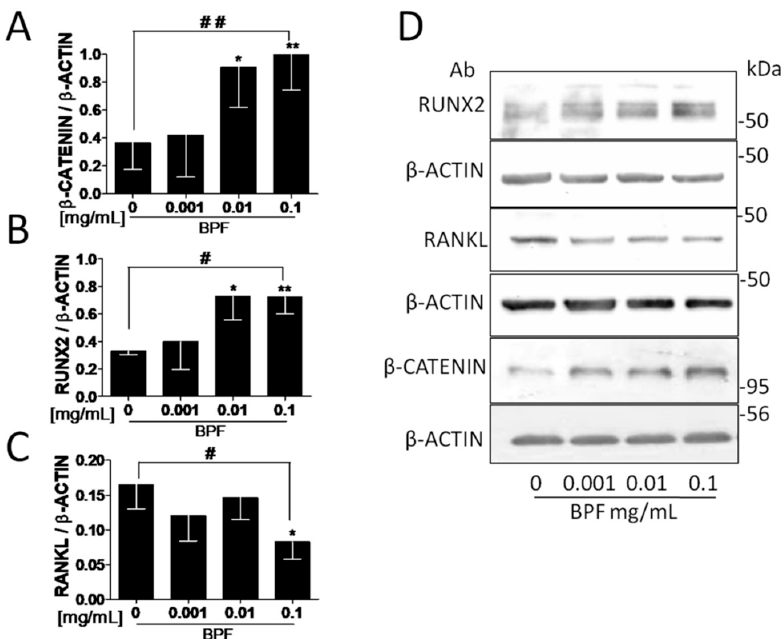
Figure 3. BPF increases β -catenin and RUNX2 and decreases RANKL protein levels on Saos-2 cells. Semi-confluent cultures of human osteoblast-like cells (Saos-2) were incubated with BPF 0.001-0.01-0.1 mg/mL for 24 h. Cell proteins were analyzed by Western blotting ( D ) with antibodies specific to ( A ) β -catenin, ( B ) RUNX2, ( C ) RANKL and β -actin. Data are represented as mean ± SD. Statistical analysis: Student’s t -test vs. 0 * p < 0.05; ** p < 0.01. Linear regression # p < 0.05; ## p < 0.01. Abbreviations: BPF, Bergamot Polyphenol Fraction; RUNX2, Runt-related transcription factor 2; RANKL,